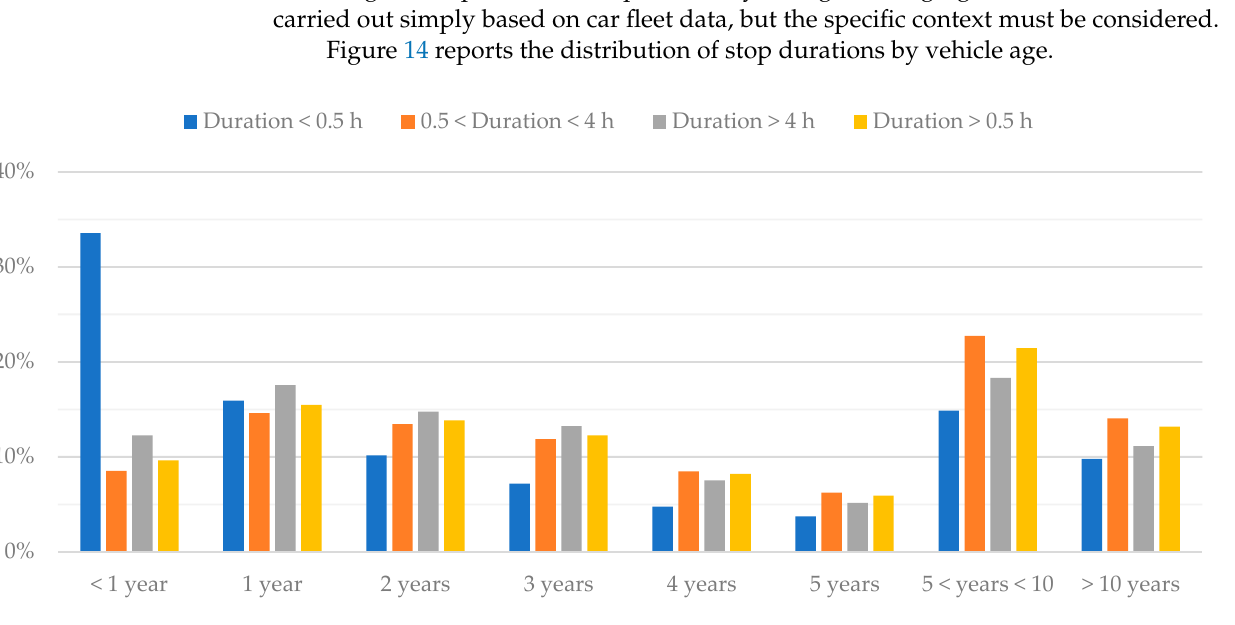
Figure 13. Comparison of vehicle registration distribution (Rome–Fiumicino airport vs. province of Rome).